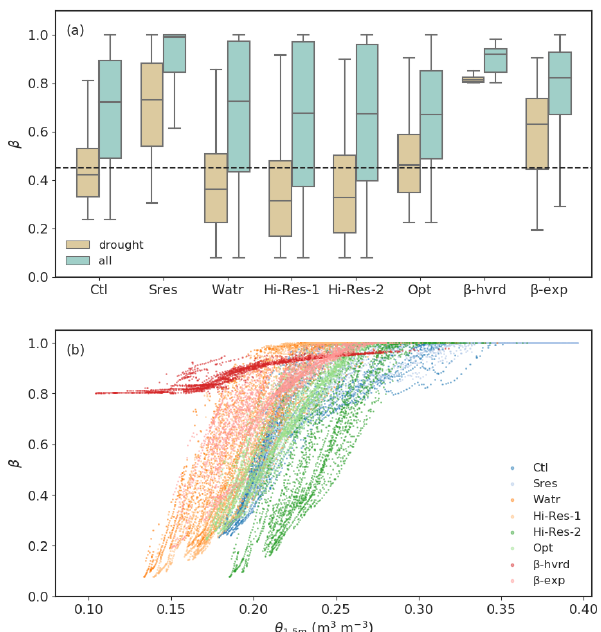
Figure 9. (a) Box plot of simulated β during a drought year (Oc- tober 2017–September 2018) and all simulated years (2013–2019). The dashed line is the mean value of β in Ctl over the dry period. (b) β variance with root-zone soil moisture over the top 1.5m ( θ 1 . 5m ) during all simulated